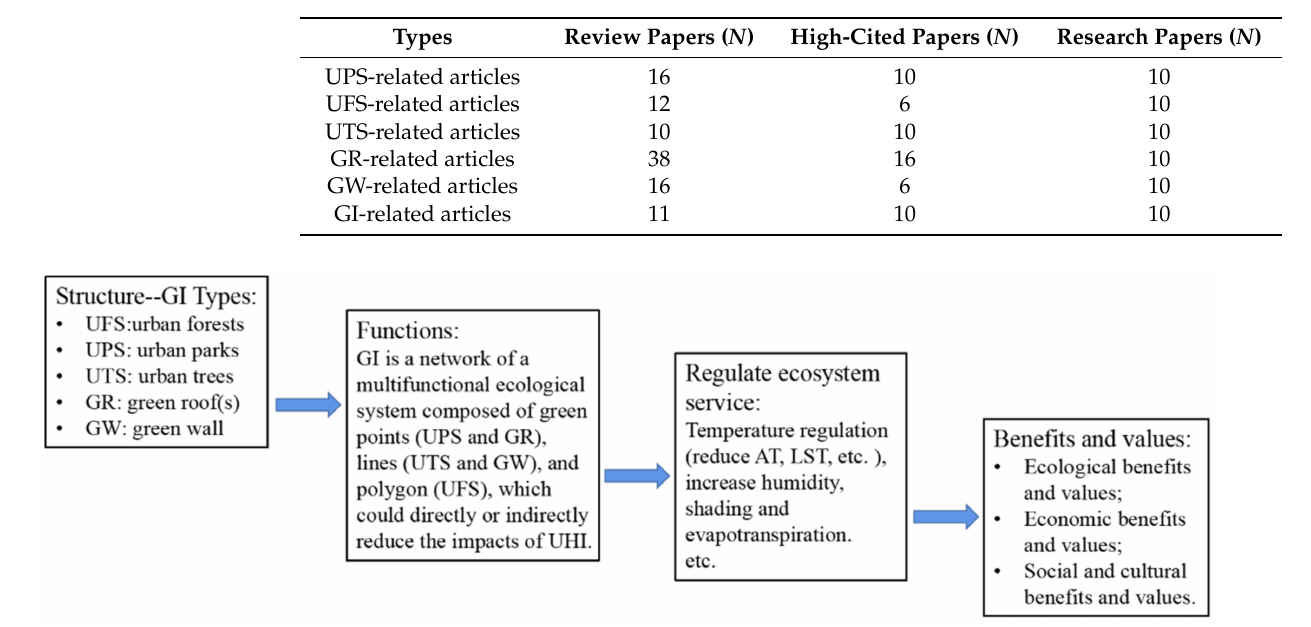
Table 5. The 221 related articles downloaded from the Web of Science.